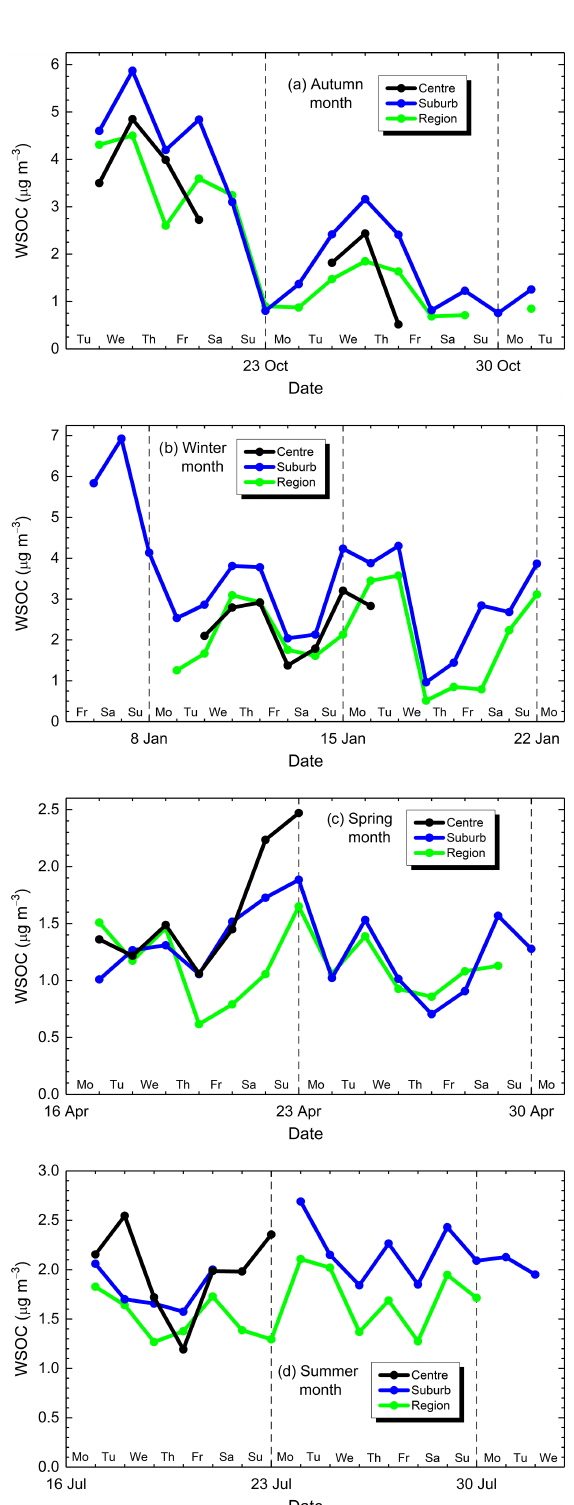
Figure 3. Time variation of EC for regional background in the Carpathian Basin, suburban area and city centre of Budapest dur- ing the aerosol sampling time intervals for different months (a–d) .